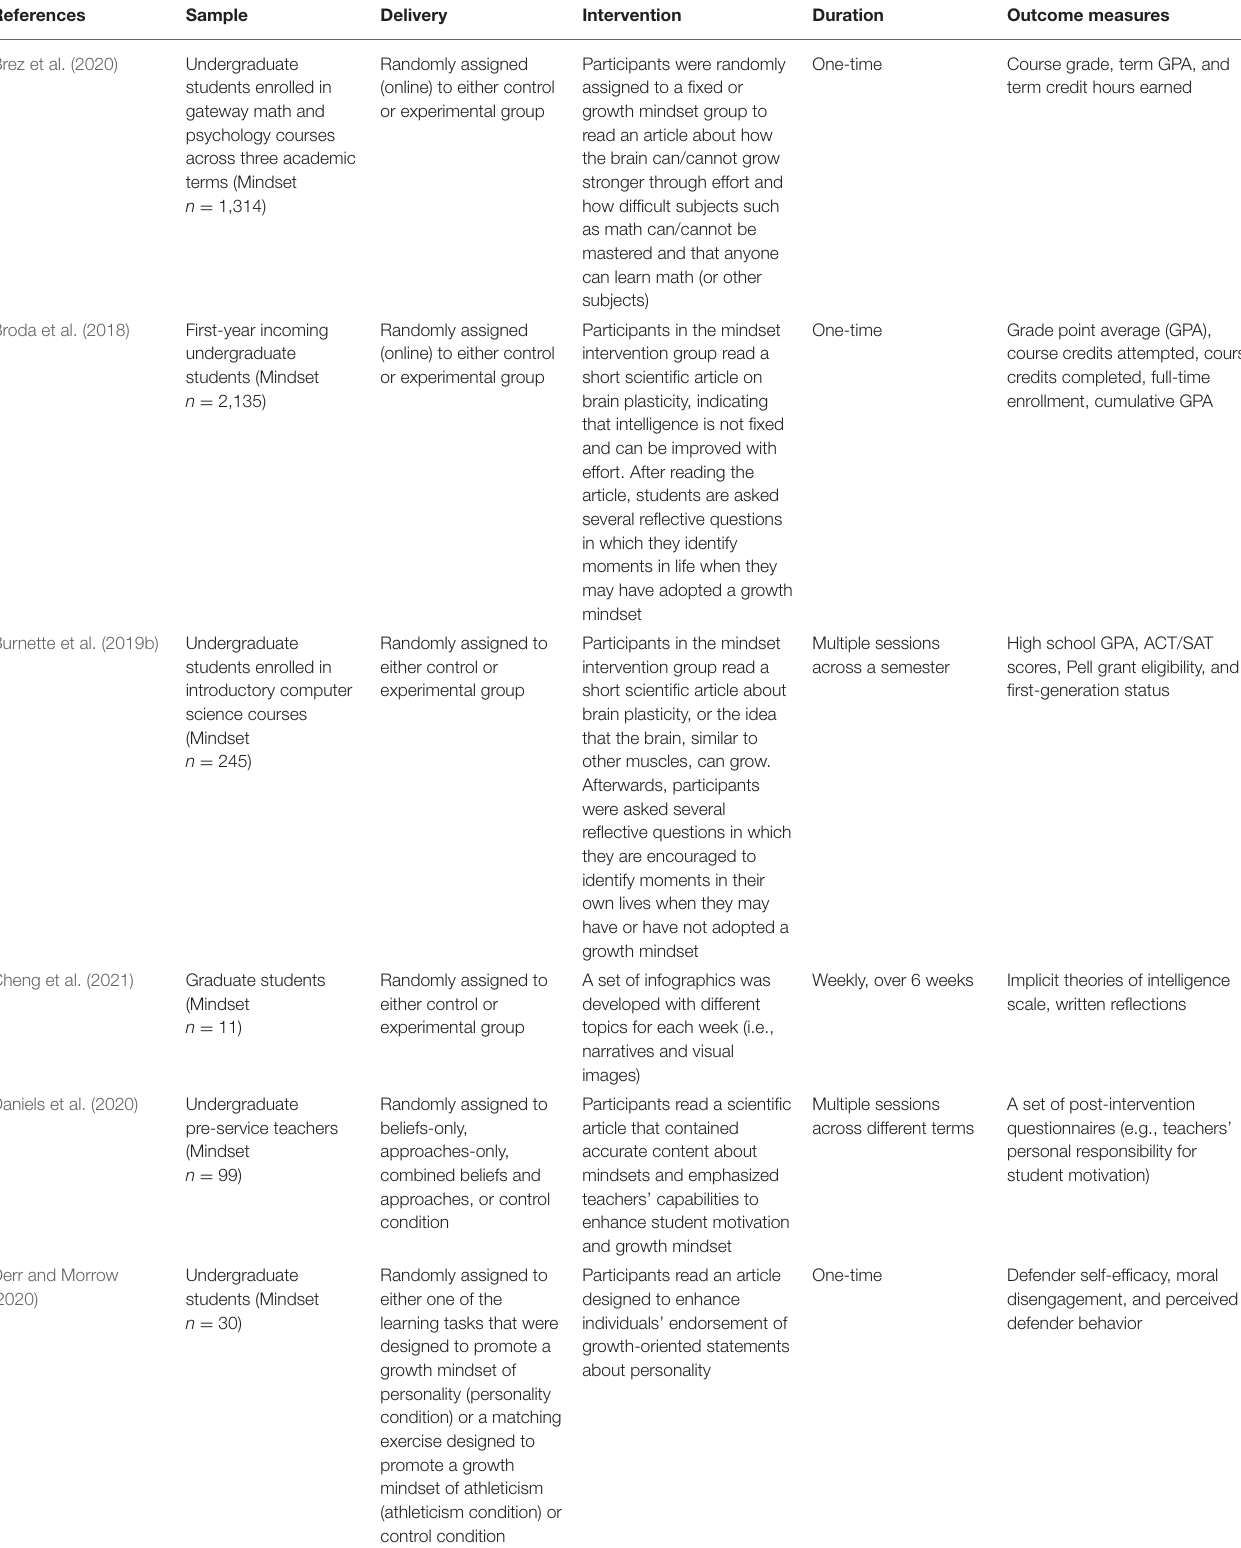
TABLE 2 | Overview of the selected